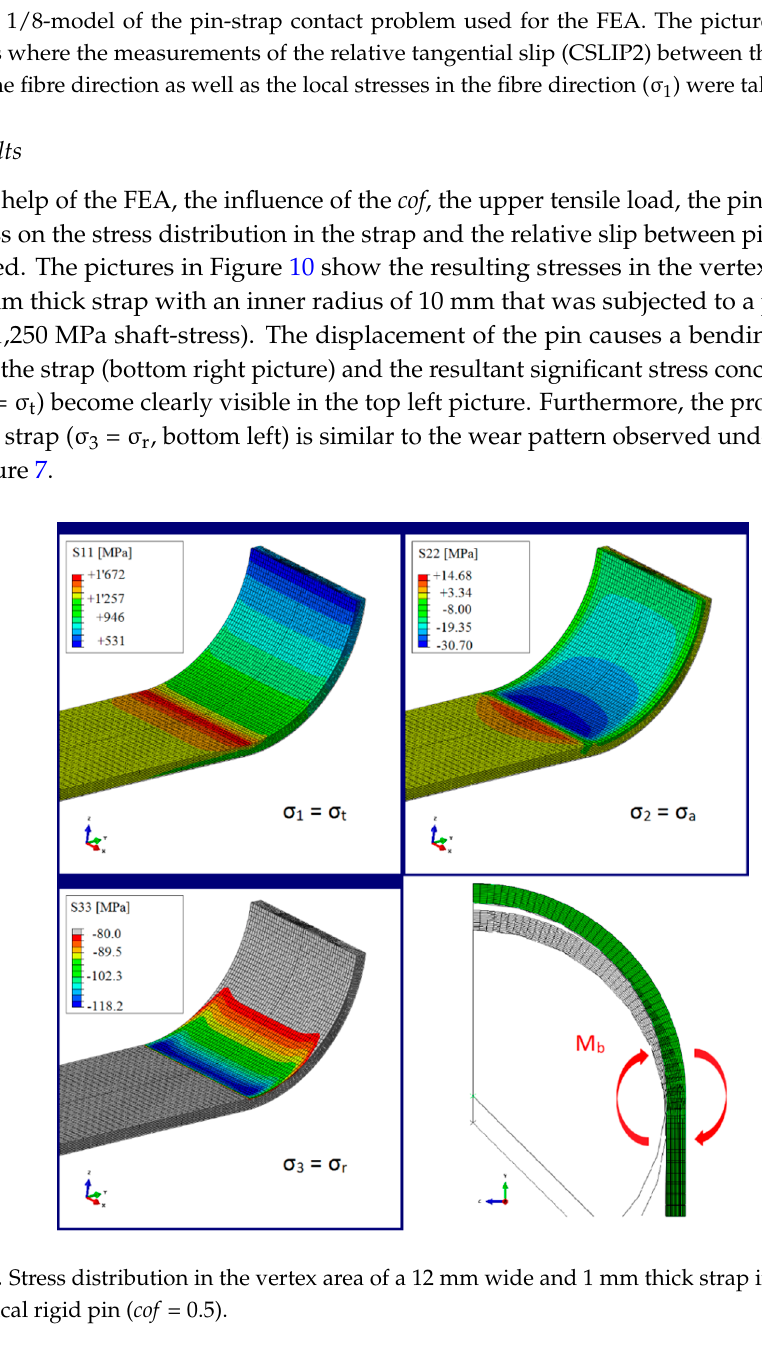
Figure 9. 1/8-model of the pin-strap contact problem used for the FEA. The picture on the right illustrates where the measurements of the relative tangential slip (CSLIP2) between the pin and the strap in the fibre direction as well as the local stresses in the fibre direction ( σ 1 ) were taken.